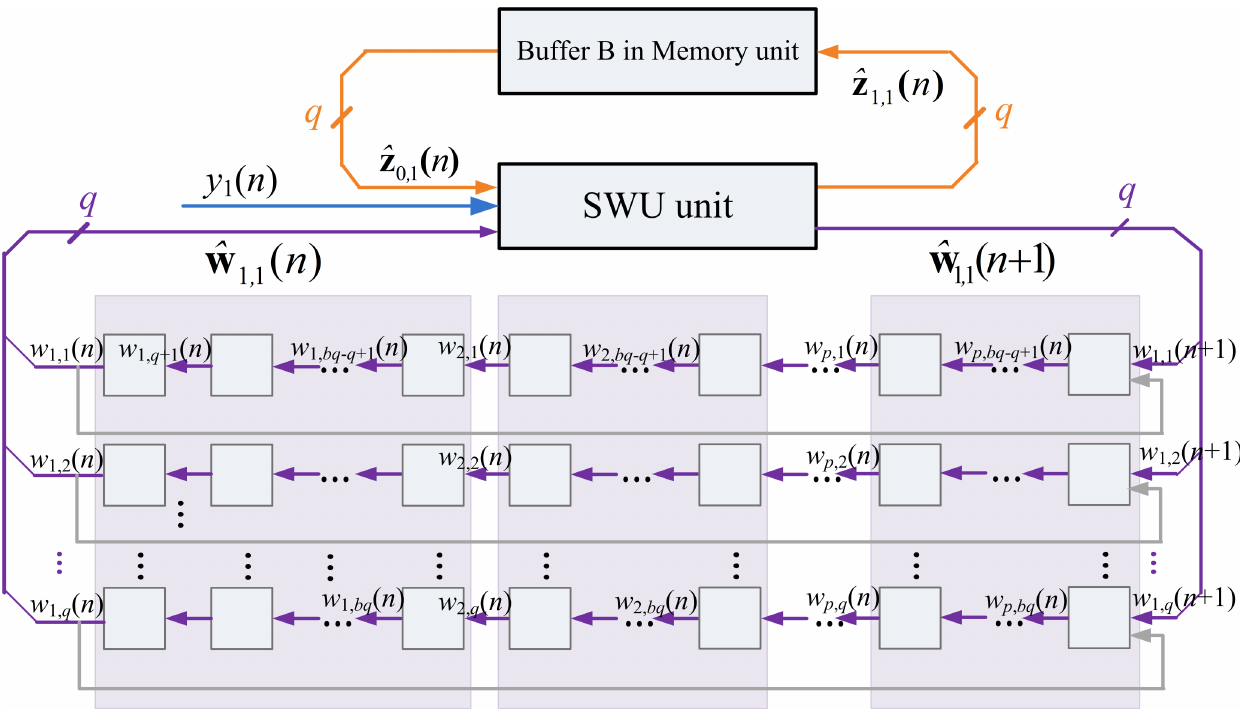
Figure 13. The Buffer C operation for the SWU